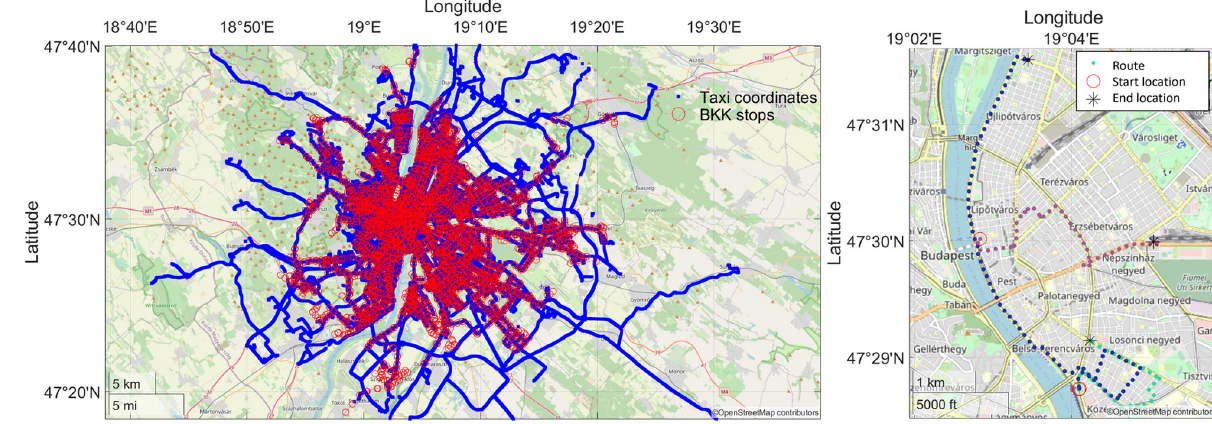
Fig 1. Stop stations of public transportation (red circles) and the travels of the Taxicabs (black lines) on the left. Some example rides with start and end location are plotted on the right side of the figure.